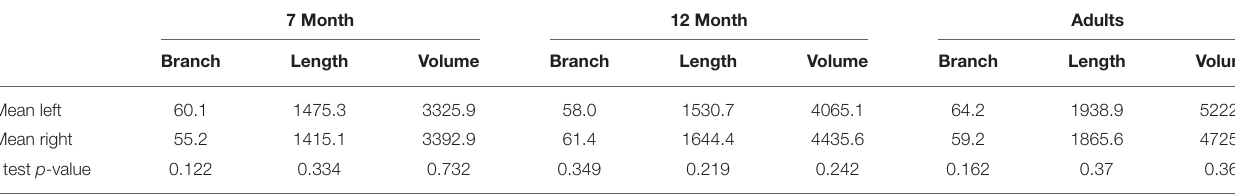
TABLE 2 | Left and right sided number of branches, length and volume in infants and adults. 7 Month 12 Month